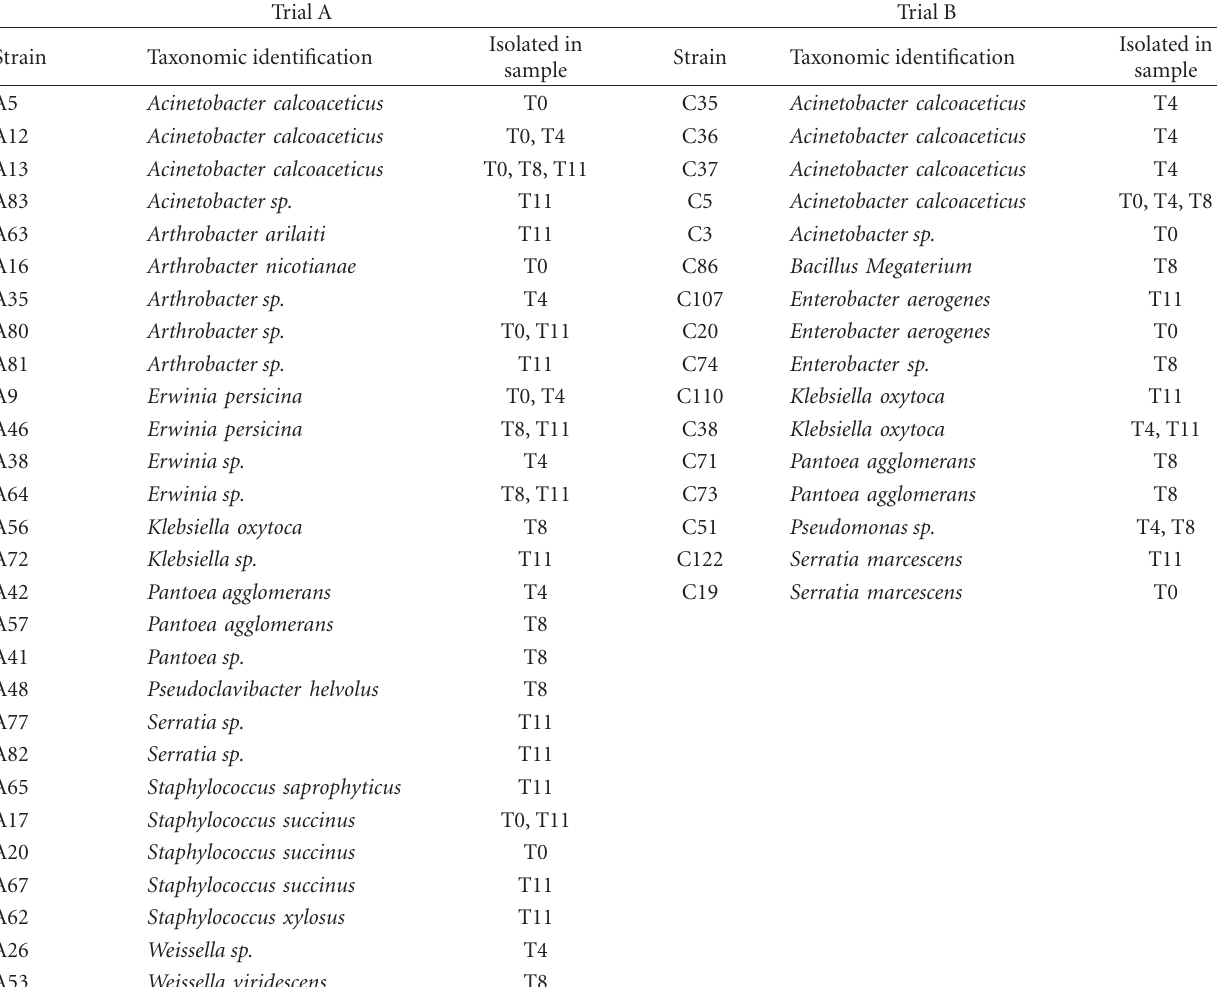
Table 1: List of strains identified from zucchini pistils harvested in Trial A and B at 0 (sample T0), 4 (sample T4), 8 (sample T8), and 11 (sample T11) days of cold